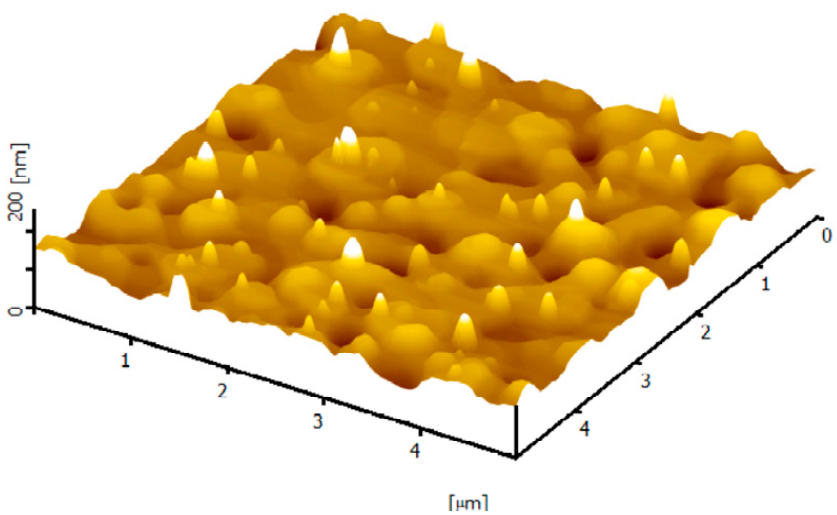
Figure 7. AFM image of YBCO film grown on an LAO substrate by using the low-fluorine rapid sol-gel route. Surface roughness of the YBCO film is 19 nm in R q (root mean square (RMS)).